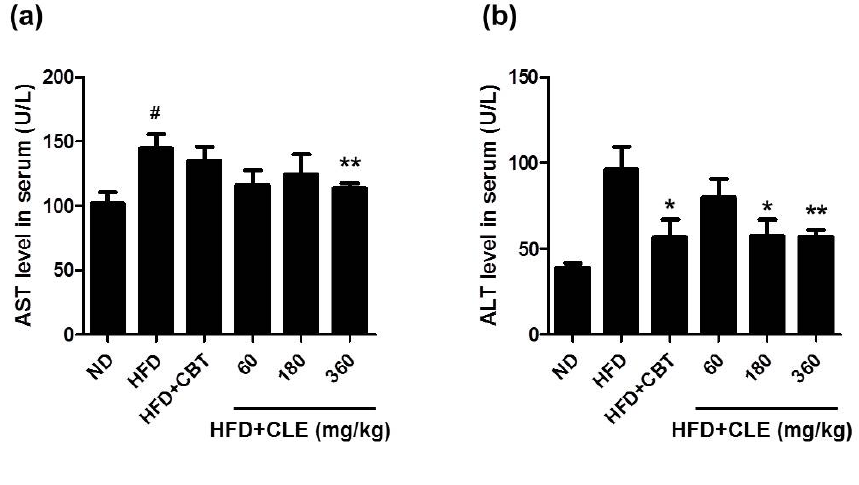
Figure 7. Effect of CLE on serum AST and ALT levels of mice fed a HFD. ( a ) Serum AST. ( b ) Serum ALT. Values are the mean ± SEM ( n = 10), # p < 0.05 vs. ND-fed mice, * p < 0.05, ** p < 0.01 vs. HFD-fed mice. ND: normal chow diet, HFD: 60% high fat diet + vehicle, HFD + CBT: 60% high fat diet + reductil (CBT, 2 mg/kg), HFD + CLE: 60% high fat diet + CLE (60, 180, and 360 mg/kg,